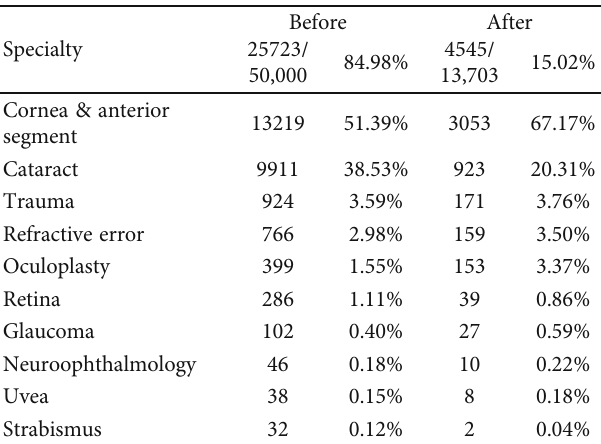
Figure 1: Decade-wise distribution of the overall cohort, teleophthalmology consults. Table 1: Patients who were referred to the secondary centre for higher care through teleophthalmology (Category